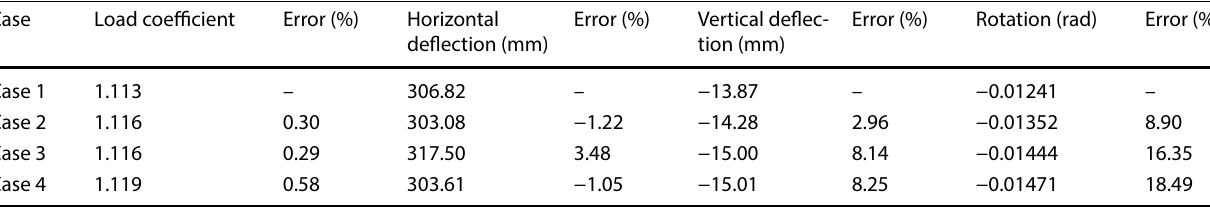
Case 1 considers both shear deformation and residual stress; Case 2 considers only residual stress; Case 3 considers only shear deformation; Case 4 does not consider both shear deformation and residual